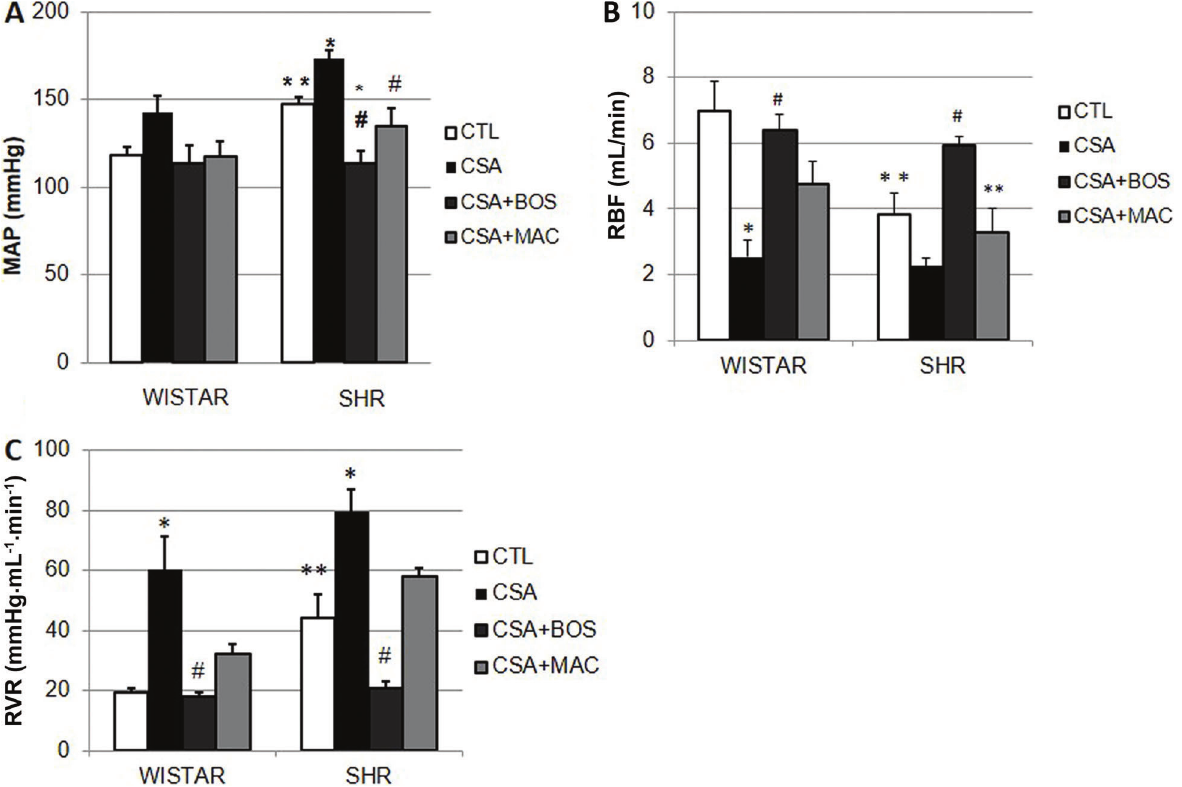
Figure 2. Quantitative analyses of A, medium arterial blood pressure (MAP); B , renal blood fl ow (RBF), and C , renal vascular resistance (RVR) in Wistar (normotensive) and genetically hypertensive (SHR) animals in the control group (CTL), rats receiving cyclosporine-A (CsA) or receiving CsA and treated with bosentan (CsA + BOS) or macitentan (CsA + MAC) for 15 days. Data are reported as means ± SE. The signi fi cance level for a null hypothesis was set at 5% (P o 0.05). *P o 0.05, compared to the CTL group; **P o 0.05, compared to the respective normotensive control group; # P o 0.05, compared to the CsA group (ANOVA followed by the Tukey test or Student ’ s t